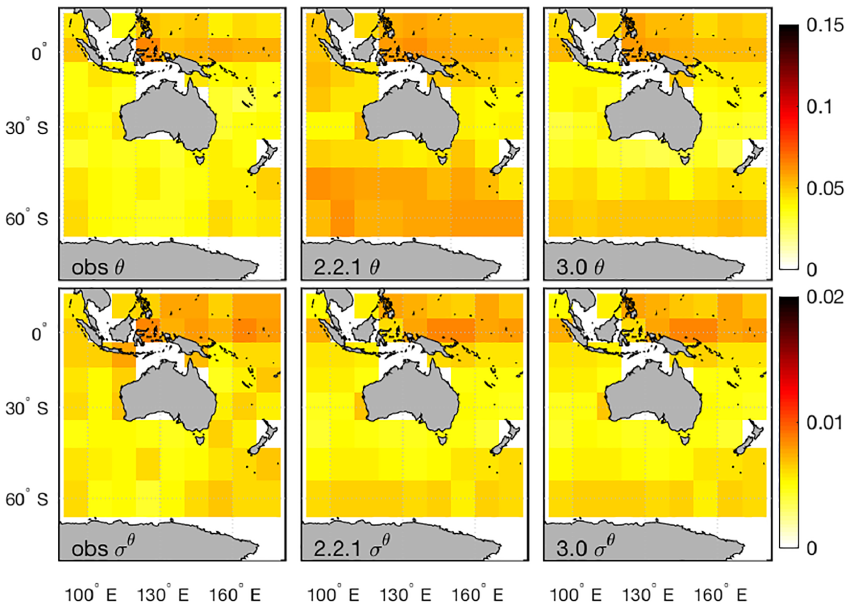
Figure 9. The mean standard deviation of the potential temperature (top row) and potential density (bottom row) above the MLD, for observations (left column), OceanMAPS version 2.2.1 (centre column) and version 3.0 (right